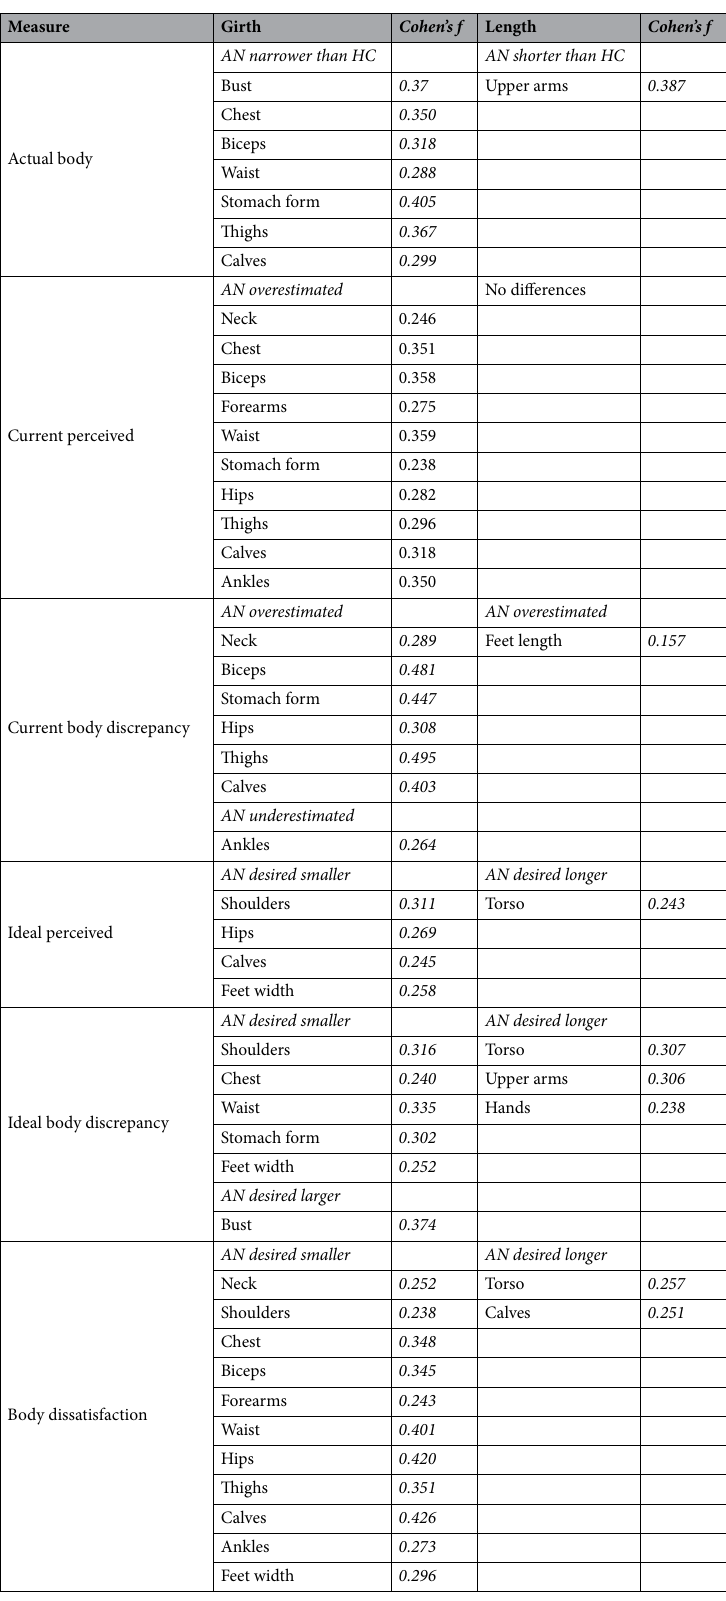
Table 2. Summary of statistically significant AN vs. HC body part differences across all six Somatomap 3D measures. 23 body part assessments (15 girth/8 length) were examined for each